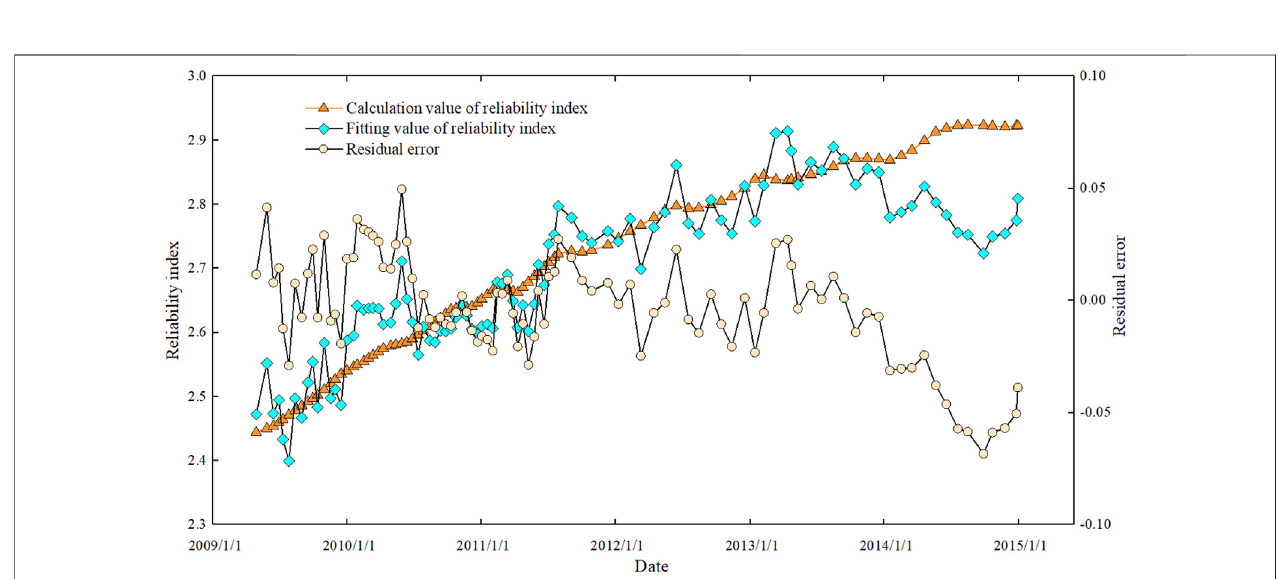
FIGURE 14 | Process line of the left bank slope stability and